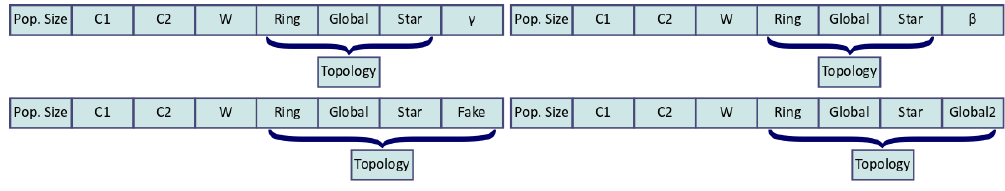
Figure A1. Encoding of PSO configurations in the four cases presented in Appendix A.2. From top left clockwise: useless parameter, harmful numerical parameter, equivalent and harmful topology. Table A4. Empirical validation of EMOPaT. Experimental settings.